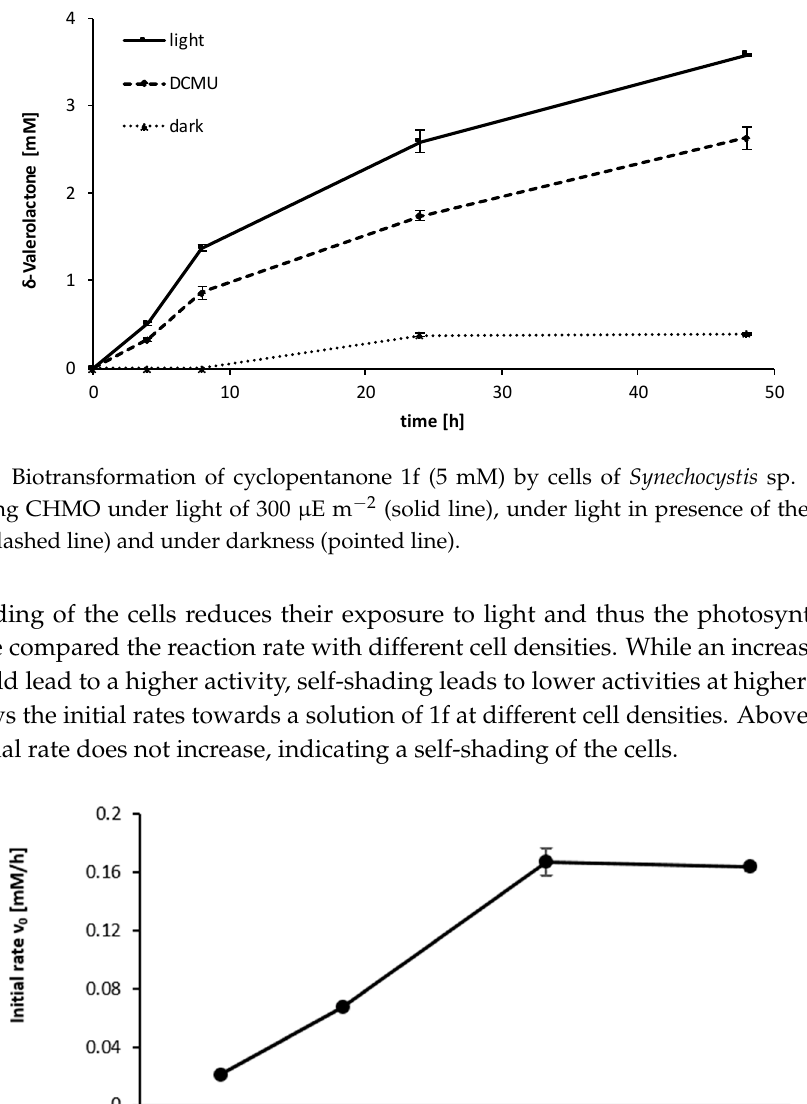
Figure 1. Biotransformation of 1f at different substrate concentrations by cells of Synechocystis sp. PCC6803 harboring CHMO under light of 300 μ E m − 2 and a cell concentration of 1.8 g/L.